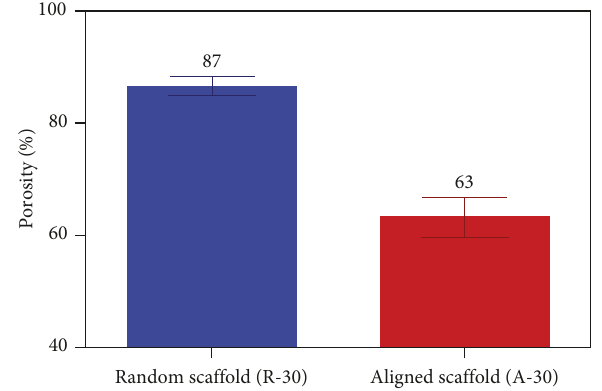
Figure 4: Te porosity of the electrospun scafolds.